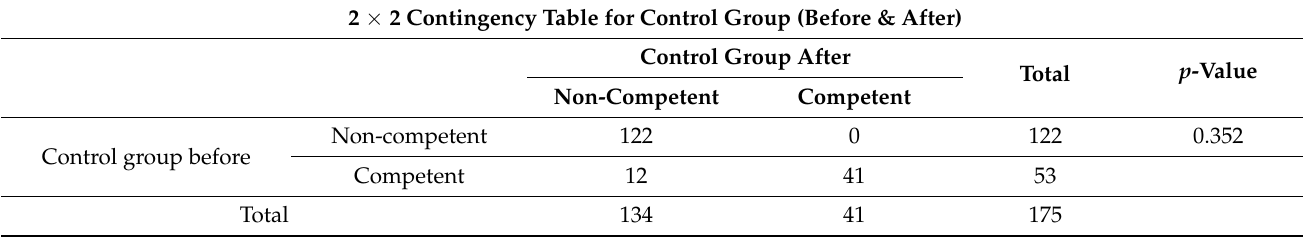
Table 1. McNemar test analysis for competent and non-competent in the control group.